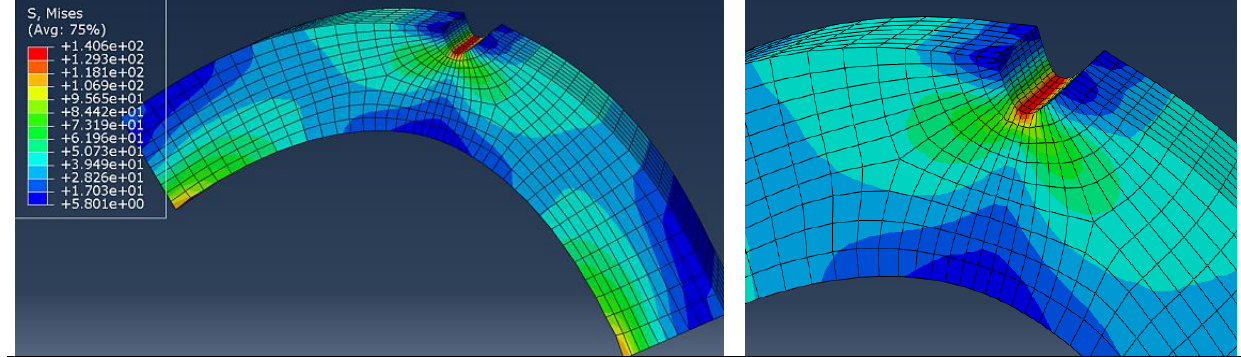
Figure 6. Distributions of Von Mises stress near the notch.